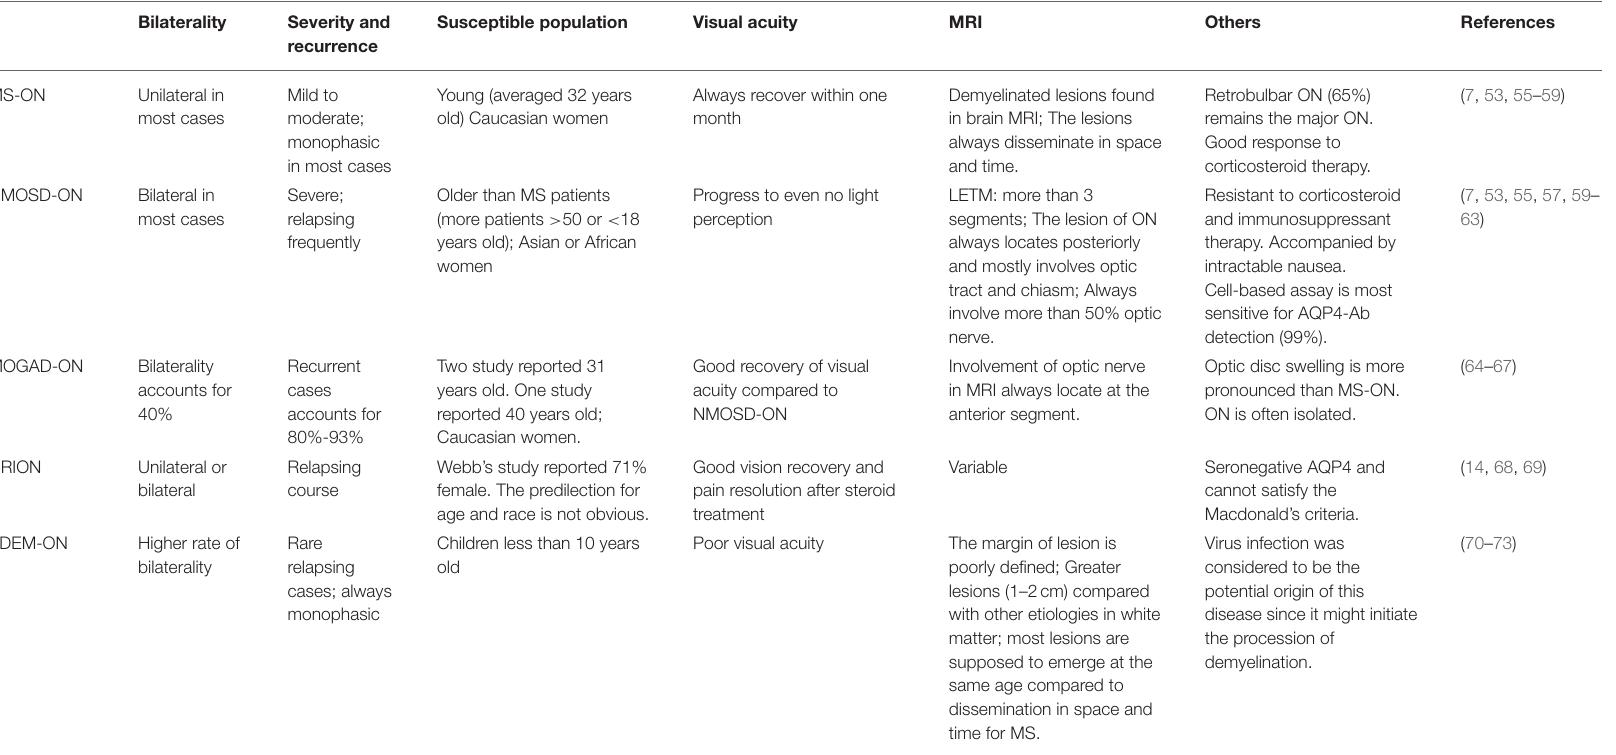
TABLE 2 | Clinical features of different disease entities that may develop